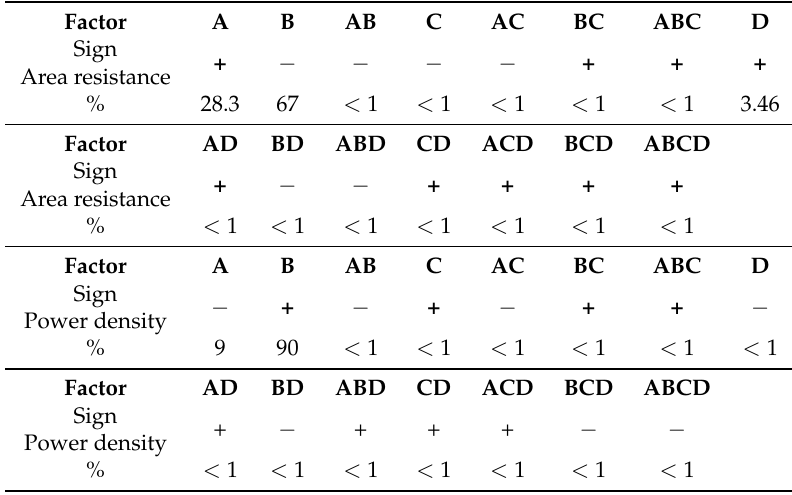
Table 8. Sign and percent contribution of area resistance and power density for each of the factors in the triangular corrugated channel shown in Table